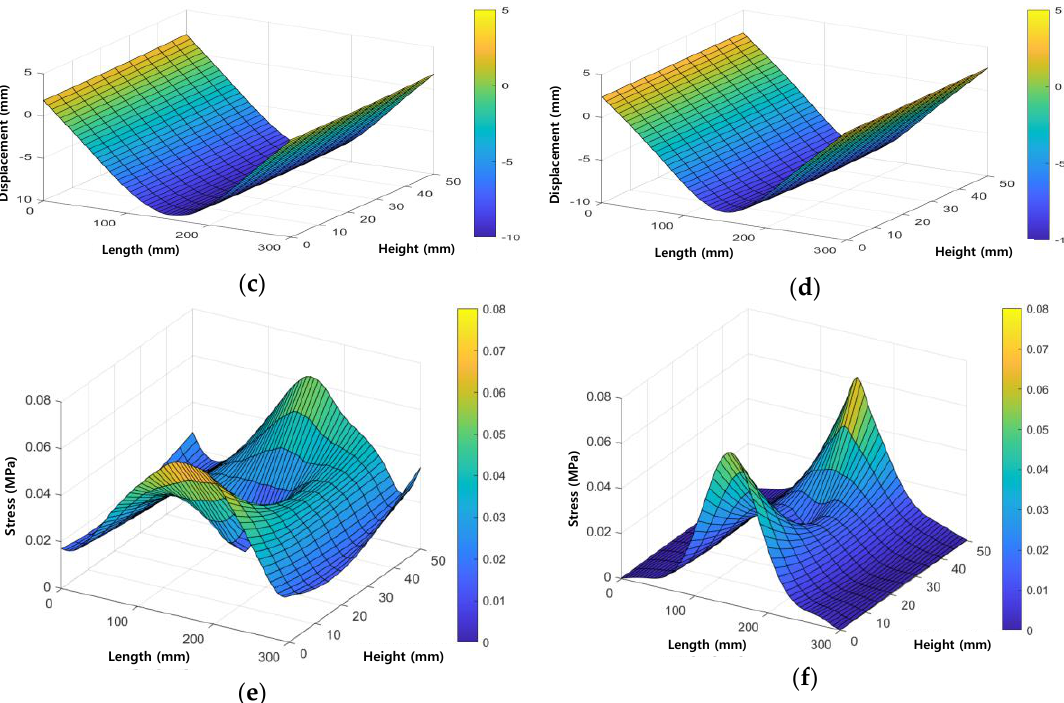
Figure 14. Analysis results at t = 60 s: ( a ) displacement in the x-direction, ( c ) displacement in the y-direction, and ( e ) von Mises stress by the synthetic structural analysis; and ( b ) displacement in the x-direction, ( d ) displacement in the y-direction, and ( f ) von Mises stress by the simulation using only PDM.